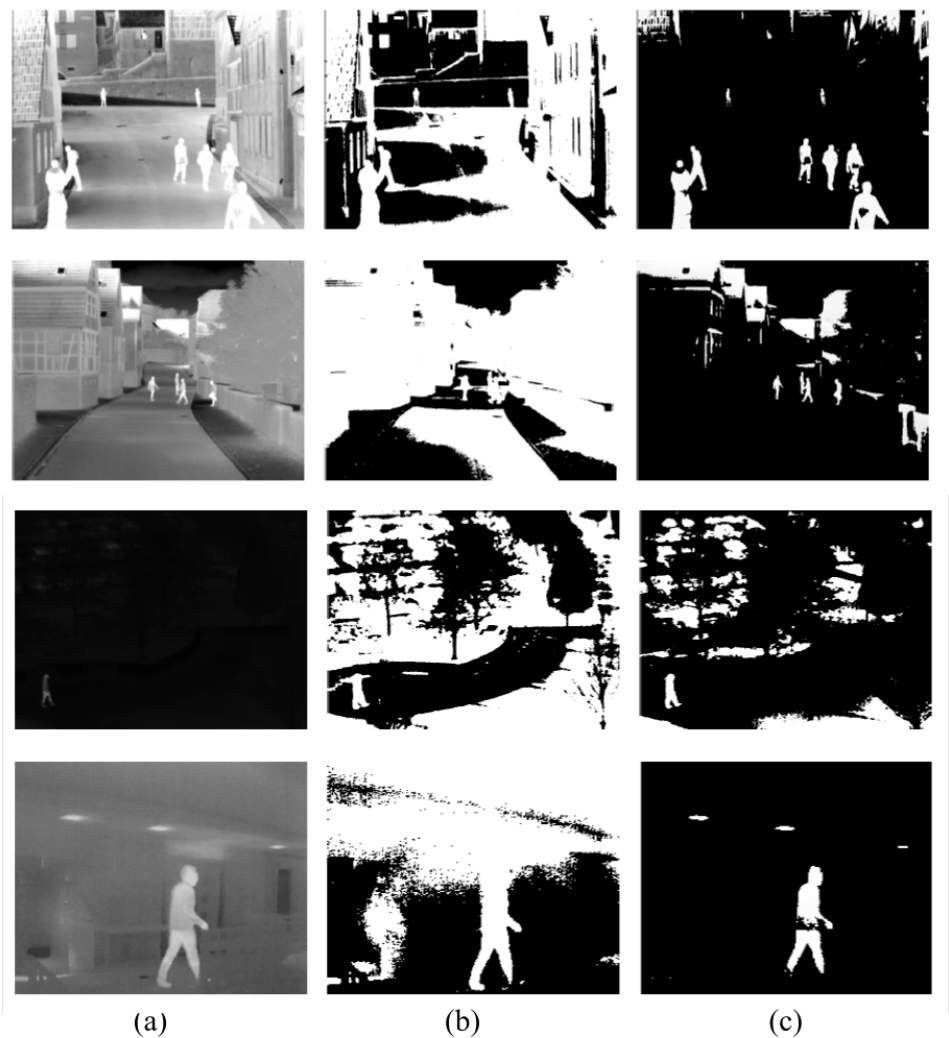
Figure 5. Comparison of outputs using MCET and the proposed method on images from the LTIR database. ( a ) Original image; ( b ) minimum cross entropy; ( c ) proposed method: Row 1: image 00000218 in Saturated; Row 2: image 00000005 in Street; Row 3: image 00000008 in Crossing; Row 4: image 00000136 in